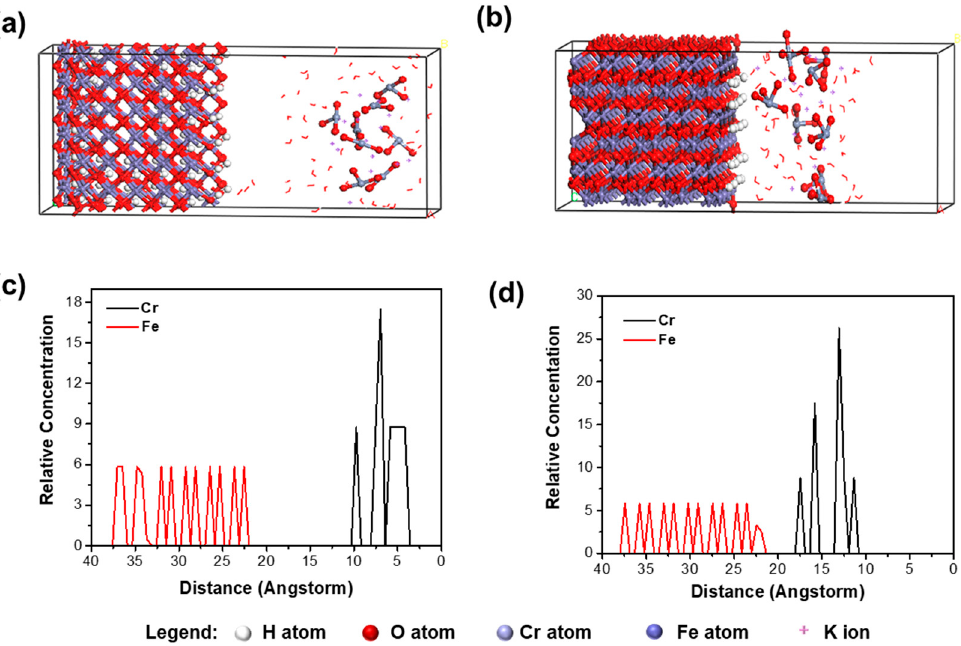
Figure 6. Fitting of Cr adsorption on (110) plane of goethite ( a ) and hematite ( b ); the distribution of Fe/Cr on (110) plane of goethite ( c ) and hematite ( d ).